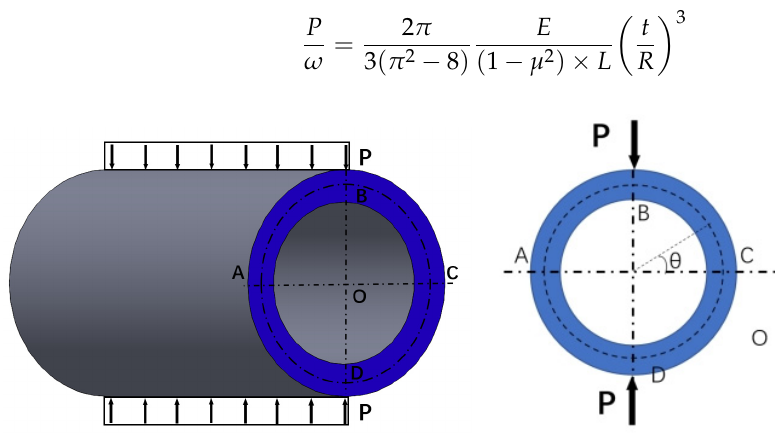
Figure 4. Schematic diagram of a hose subjected to lateral crush load.